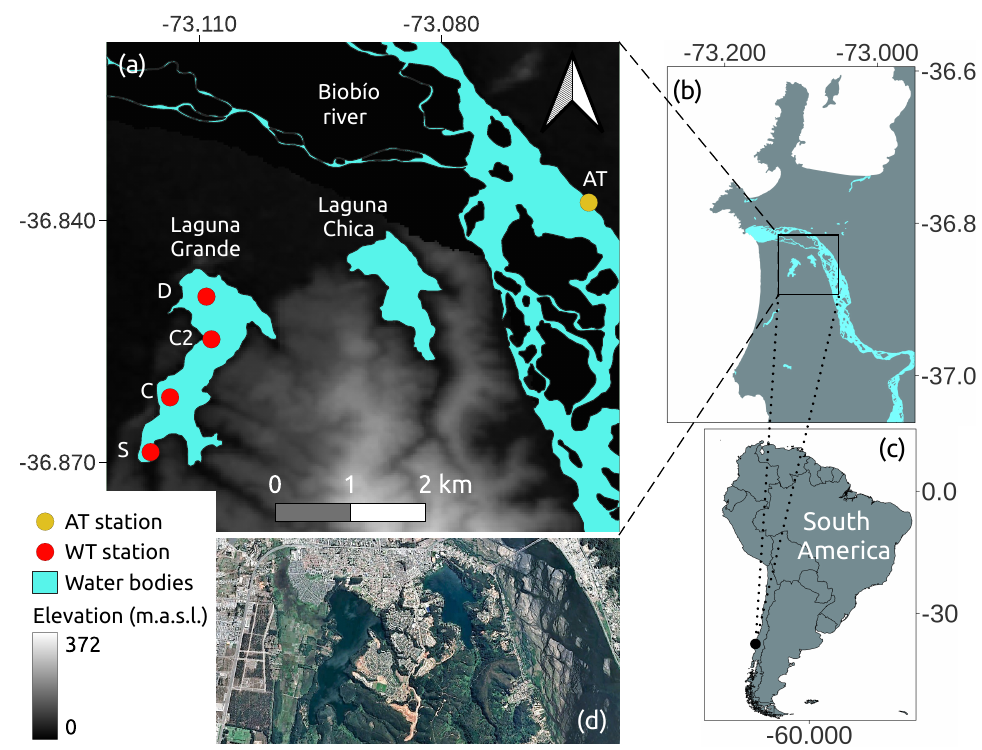
Figure 1. ( a ) Study lagoons. Water temperature (WT) stations (Desagüe (D), Centro (C), Sur (S) and Centro 2 (C2)) are represented by red dots. Water bodies are in cyan. Air temperature (AT) station is in yellow dot. ( b ) Zoom out of the study lagoons area. ( c ) South America. ( d ) Google Earth image of the study